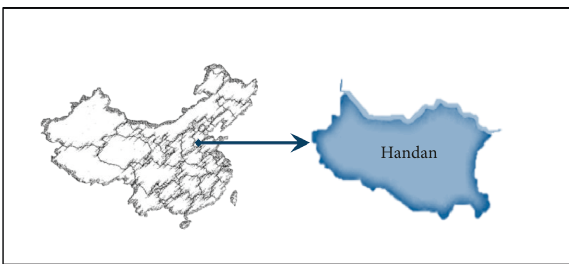
Figure 1: Location of Handan in Hebei Province.